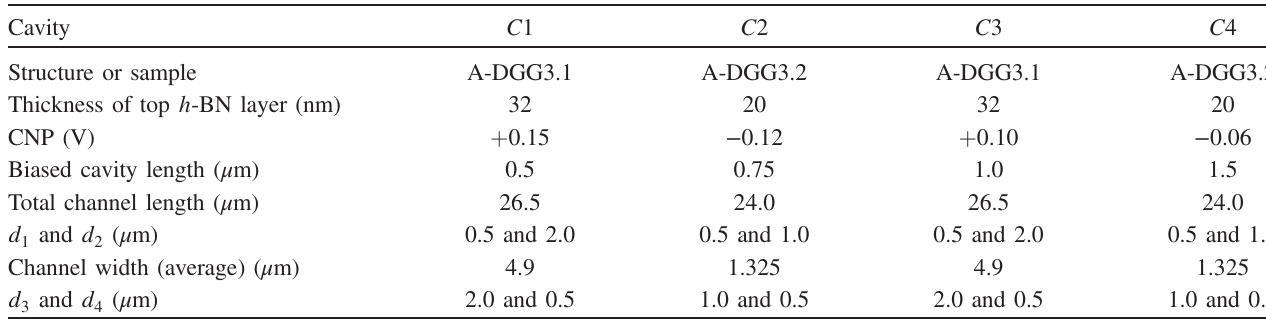
TABLE I. Samples and different plasmonic cavity parameters. Cavity C 1 C 2 Structure or sample